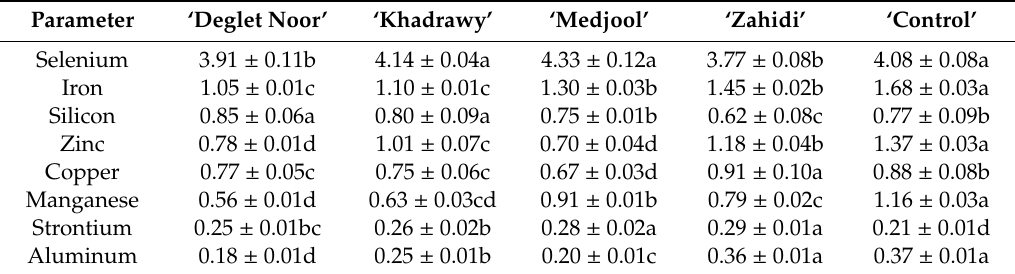
Table 6. Total microminerals content for four pollen source treatments and control for a recipient ‘Medjool’ cultivar. Control is a pollen mixture from random date palm male plants, used by the grower. All parameters are expressed in mg / 100 g dry weight.